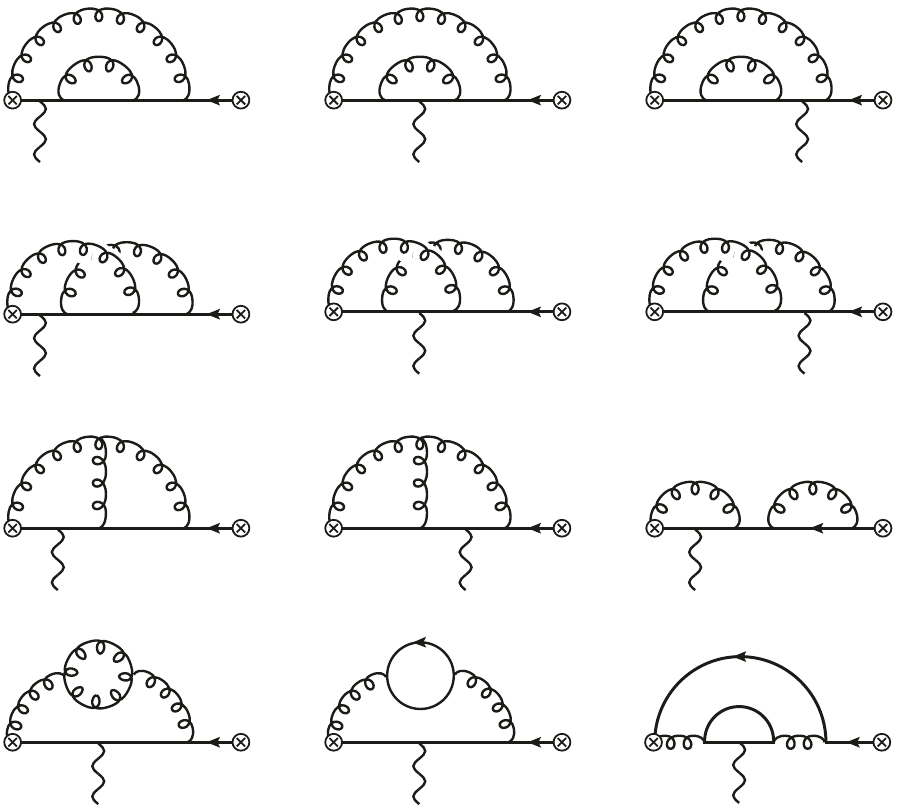
Figure 1 . Non-vanishing two-loop Feynman diagrams contributing to J G in light-cone gauge. Graphs with other photon attachments vanish, because they involve scaleless integrals. There are two contributions from the last diagram with di(cid:11)erent orientations of fermion-number (cid:13)ow in the inner loop. Their sum vanishes because of Furry’s